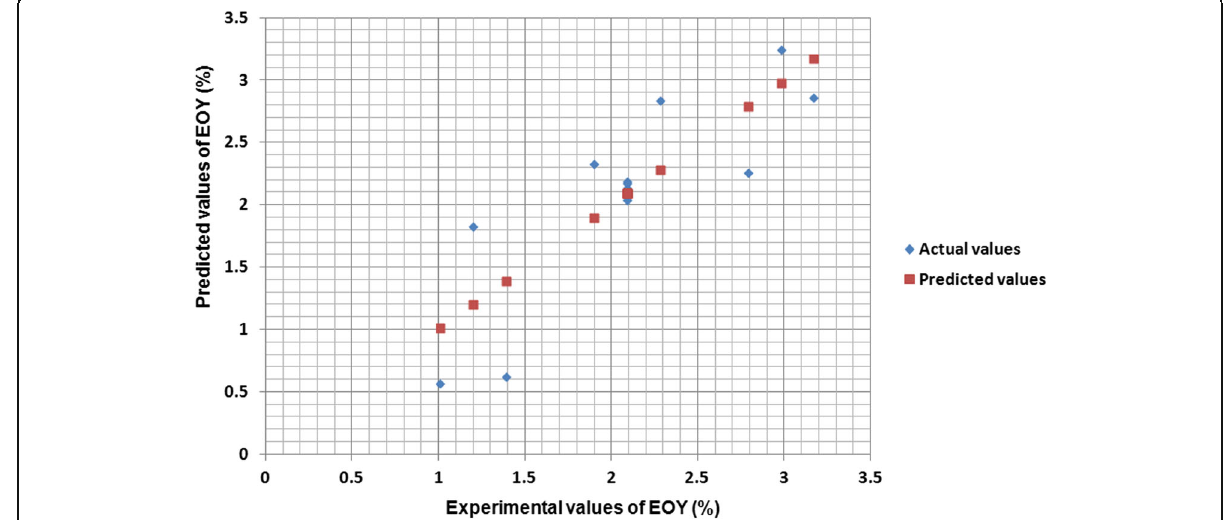
Fig. 5 Predicted and actual values for essential oil